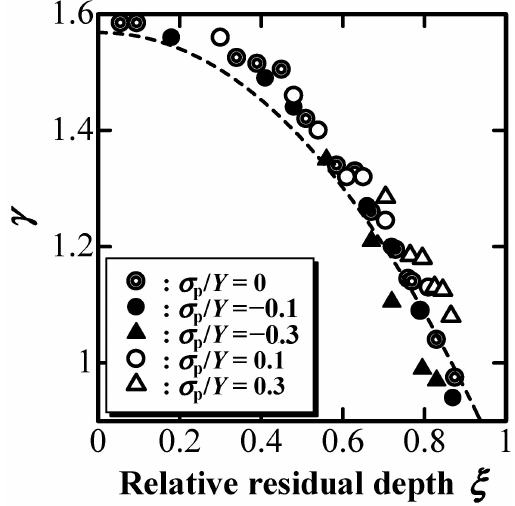
Figure 5. γ affected by EBPS as a function of ξ